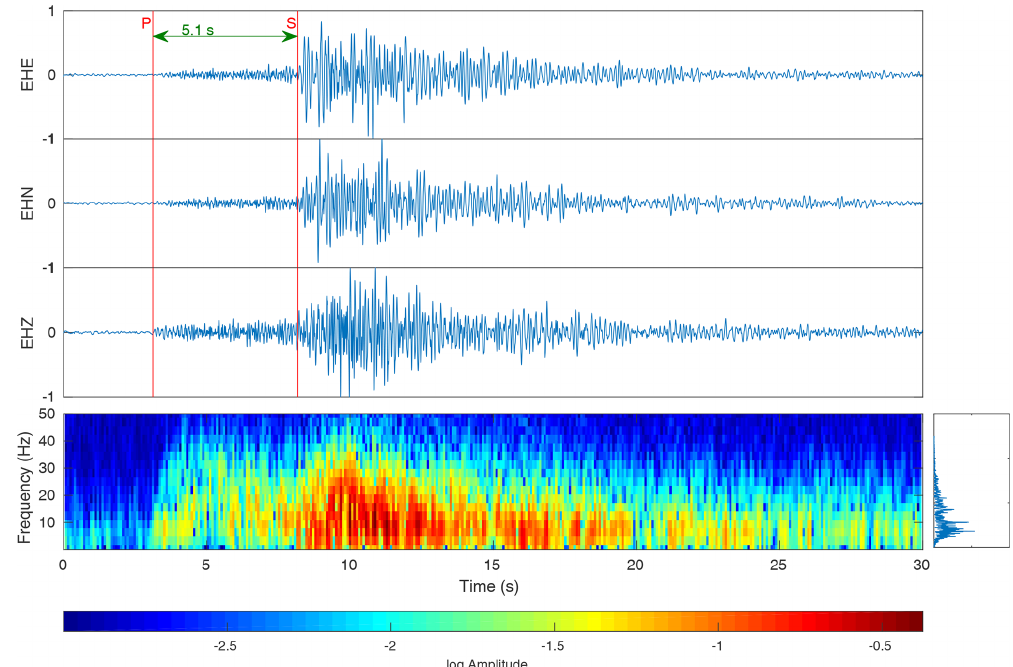
Figure 4. Top: example of a typical earthquake near Brava, recorded on 2 August 2016, 01:13 (UTC), at a short-period station of the array on Fogo. A Butterworth filter is applied with cutoff frequencies of 0.5 to 50Hz and traces are normalized. Bottom left: spectrogram of the vertical component. Bottom right: frequency content of the recording.